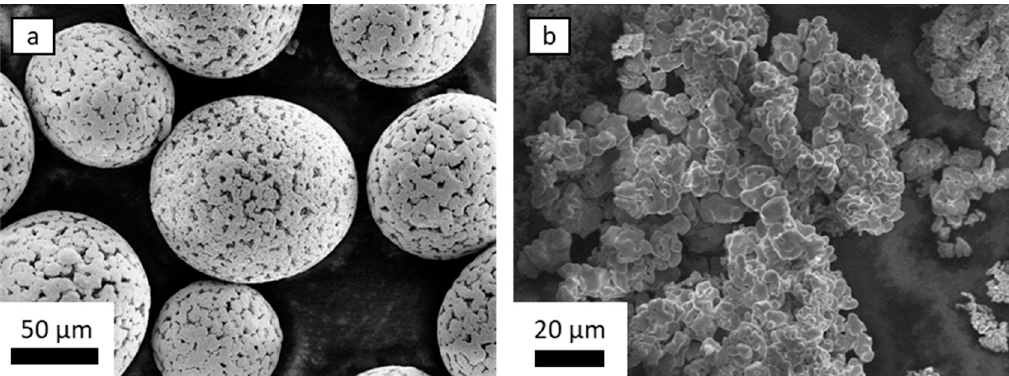
Figure 1. scanning electron microscopy (SEM) micrographs of Co particles. The main difference is the particle shape, the purity, and the resulting grain size. ( a ) Purity 99.9%. ( b ) Purity 99.998%.